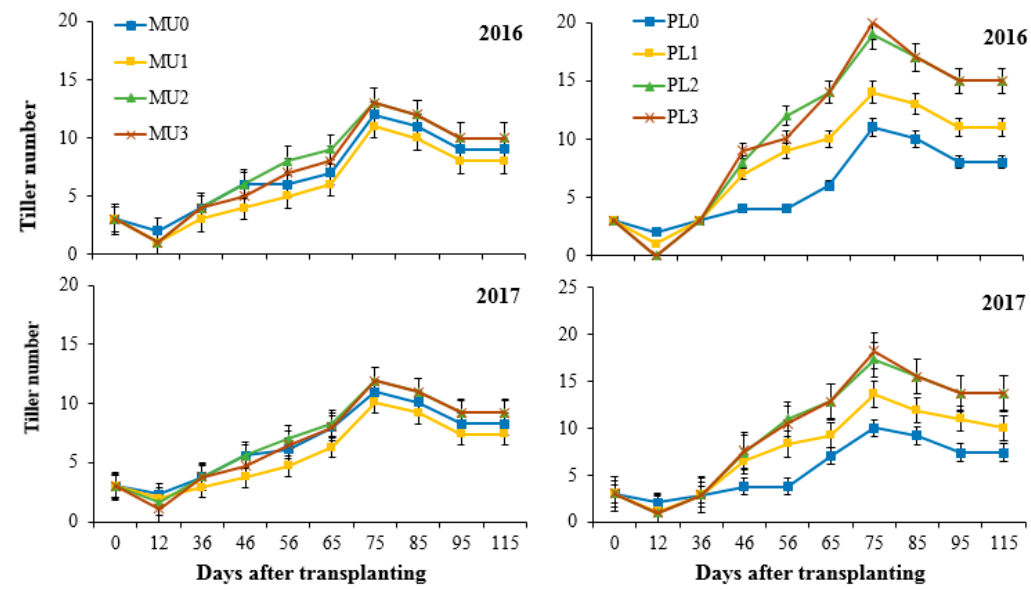
Figure 2. Dynamic changes of rice tillers under di ff erent straw incorporation treatments during 2016 and 2017. MU 0 , MU 1 , MU 2 , and MU 3 represent 0.0 t / hm 2 , 1.5 t / hm 2 , 3.0 t / hm 2 , and 4.5 t / hm 2 of straw, respectively, which were incorporated in soil by a mulching method. Whereas PL 0 , PL 1 , PL 2 , and PL 3 represent 0.0 t / hm 2 , 1.5 t / hm 2 , 3.0 t / hm 2 , and 4.5 t / hm 2 of straw, respectively, which were incorporated in soil by a plowing method. Impacts of straw incorporation on the dynamics of root